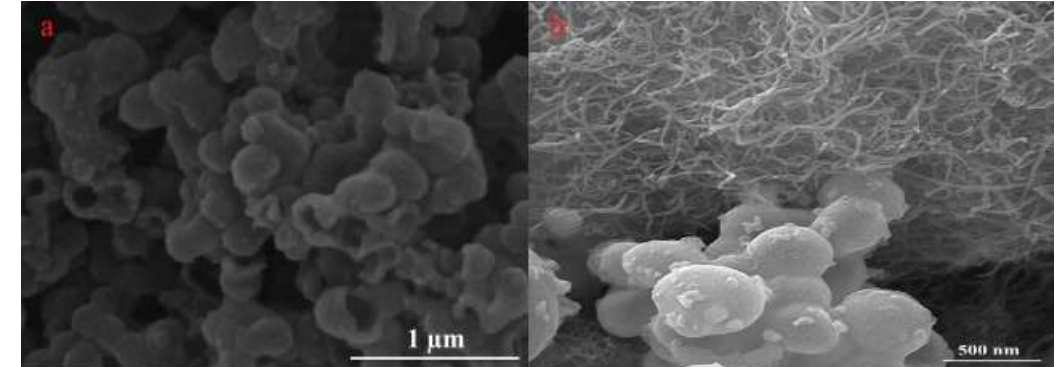
Fig. 2. SEM image of the TOHS (a) and TOHS/MWCNTs/Carbon composite